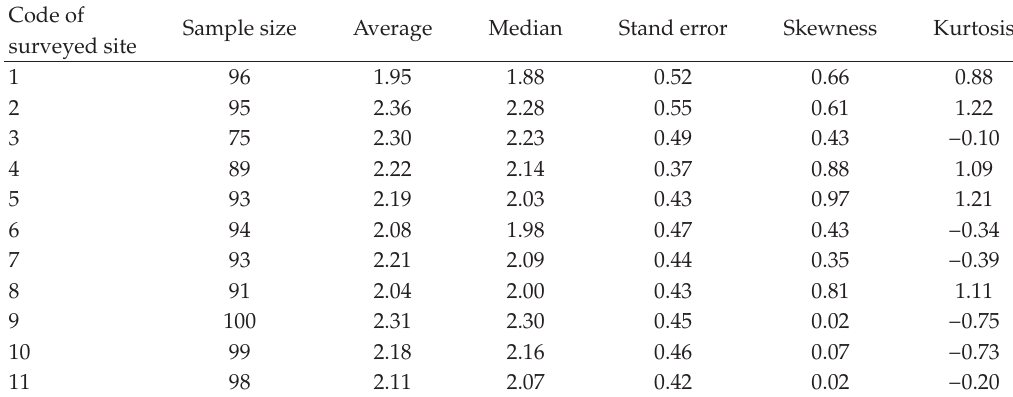
Table 1: Statistical results for the queue discharge